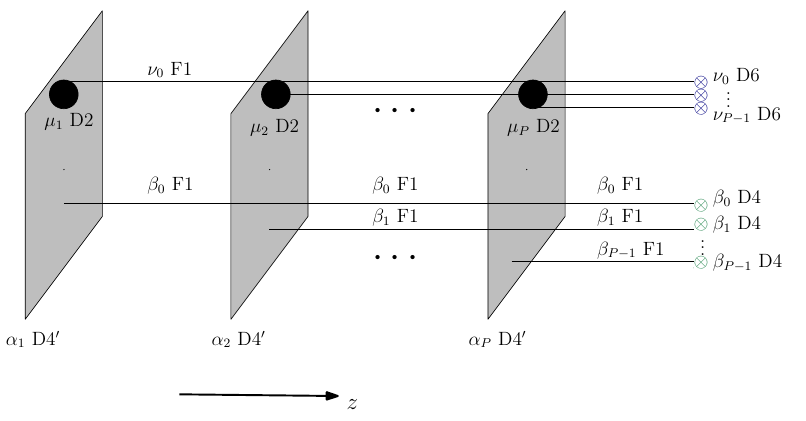
Figure 4 . Hanany-Witten brane set-up equivalent to the brane configuration in figure